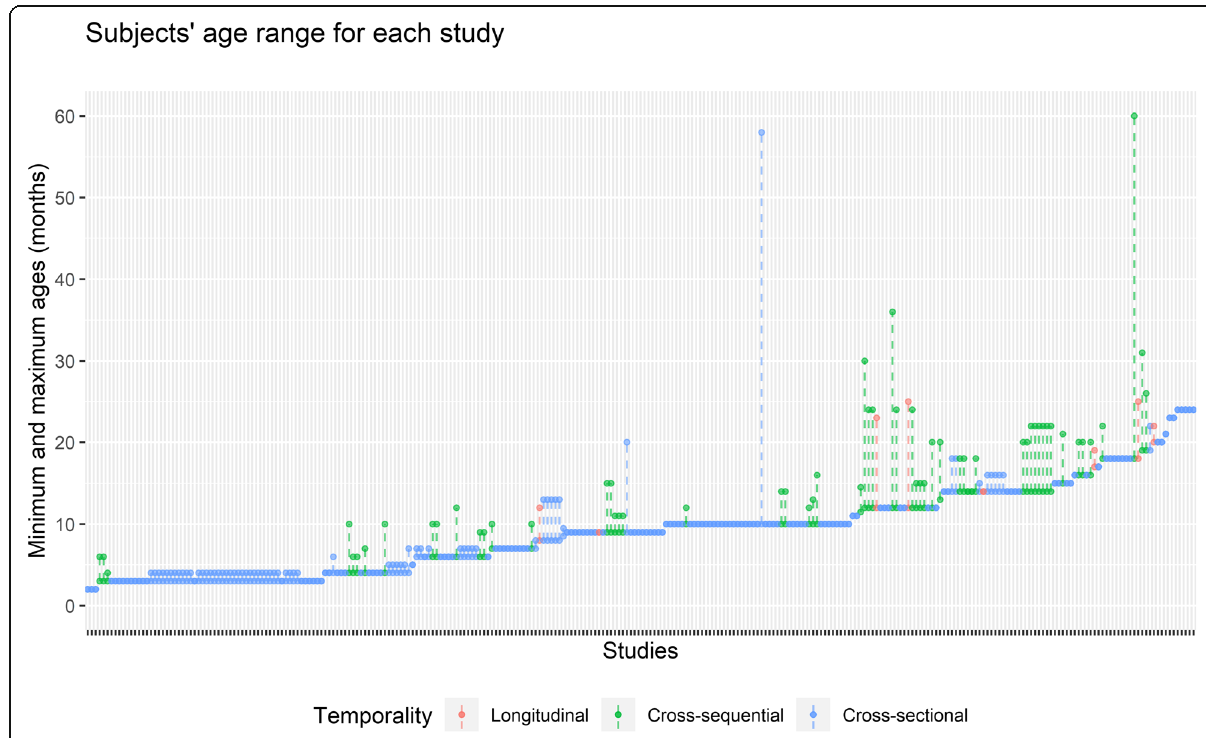
Fig. 3 Subjects ’ age range for each